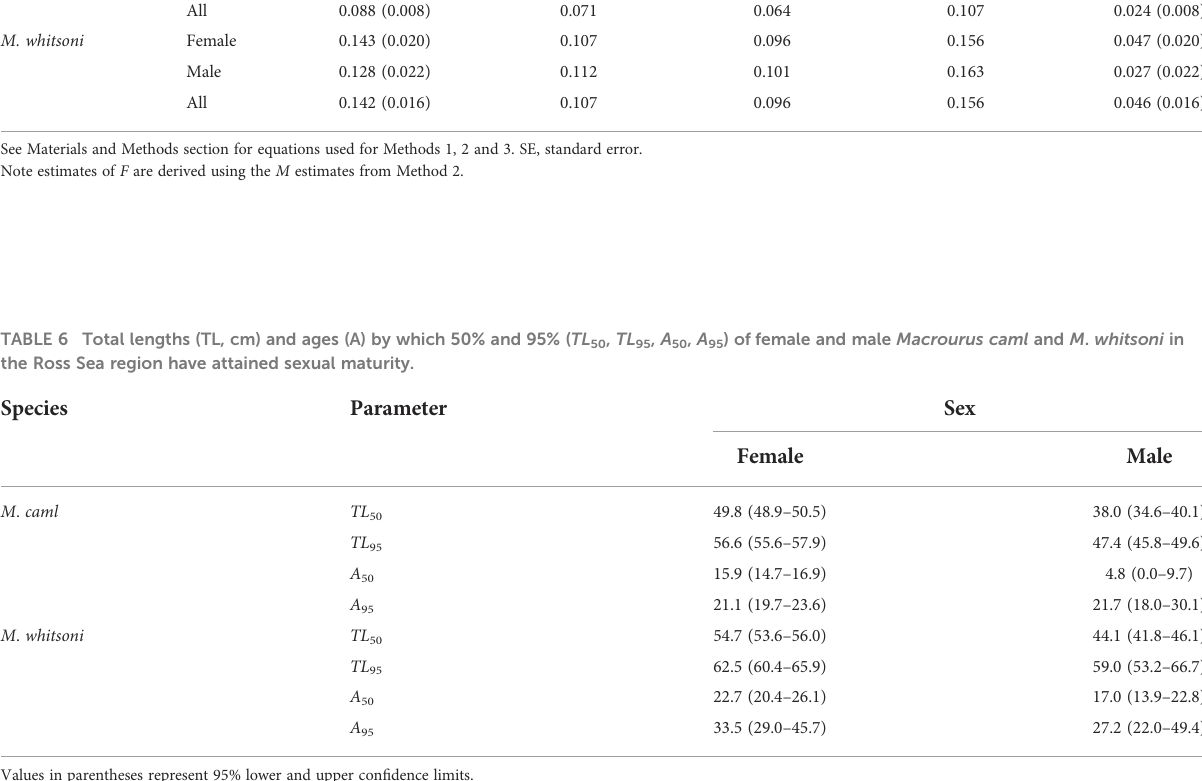
Values in parentheses represent 95% lower and upper con fi dence